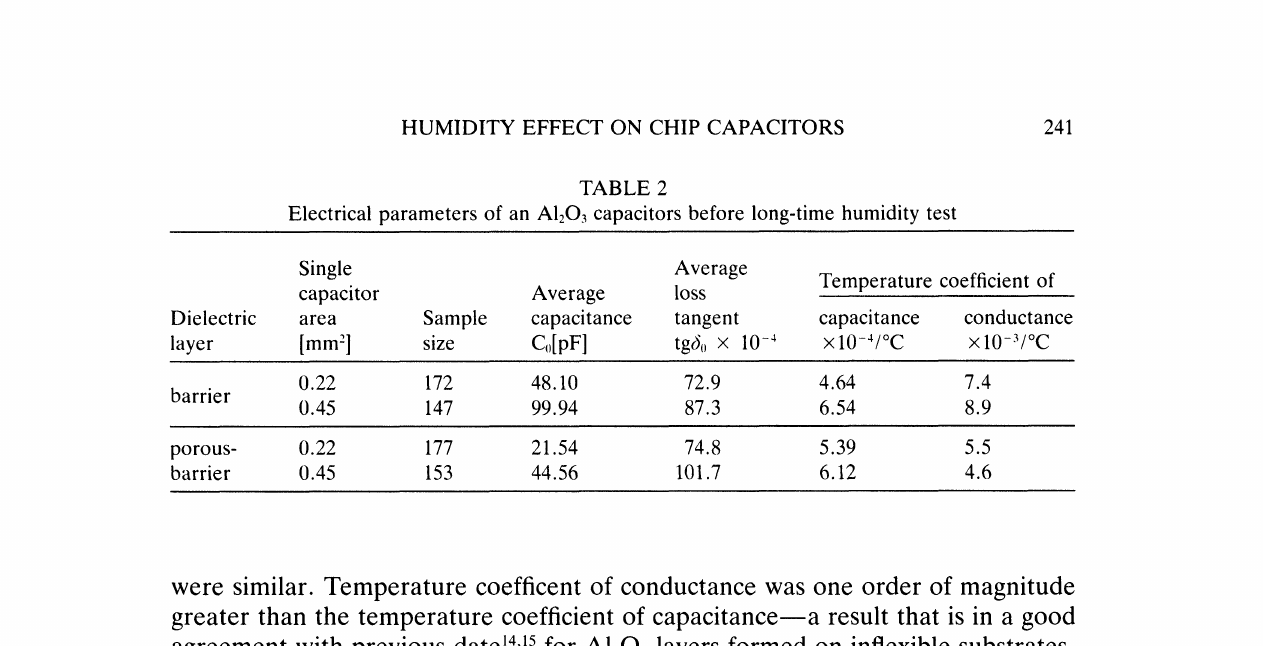
Electrical parameters of an A1203 capacitors before long-time humidity